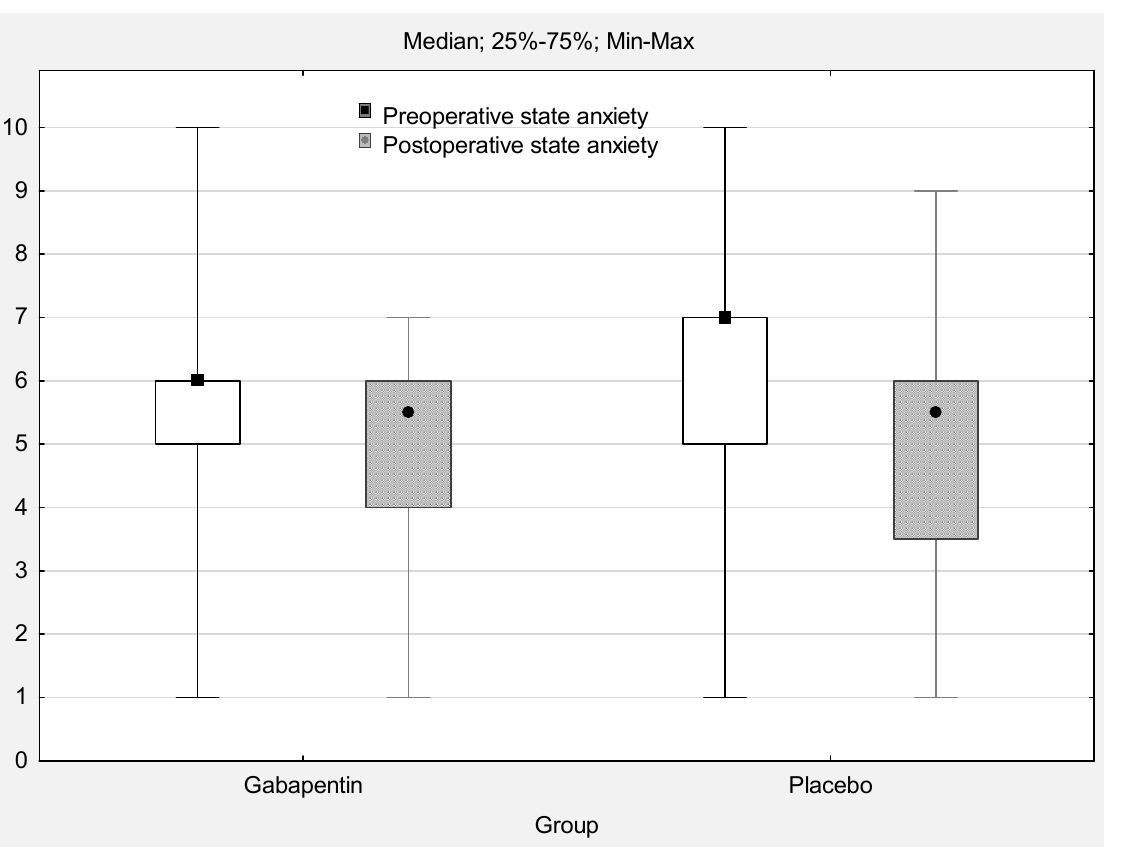
Figure 3. Pre- and postoperative state anxiety (sten; range 0–10; p < 0.05).